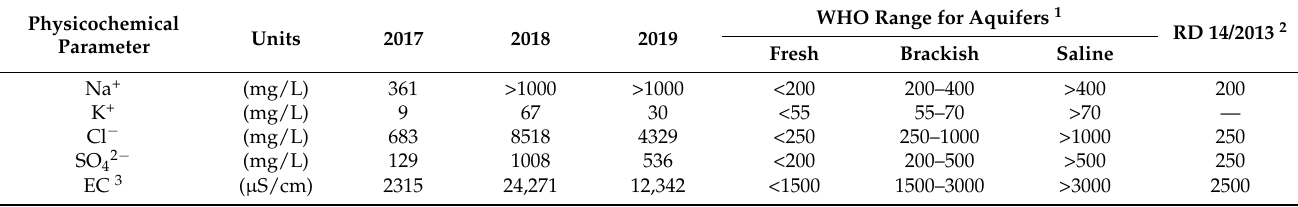
Table 2. Salinity indicators results of Port de la Selva aquifer control point compared to World Health Organization suggested groundwater classification and Spanish sanitary guidelines for the quality of water for human consumption. Physicochemical